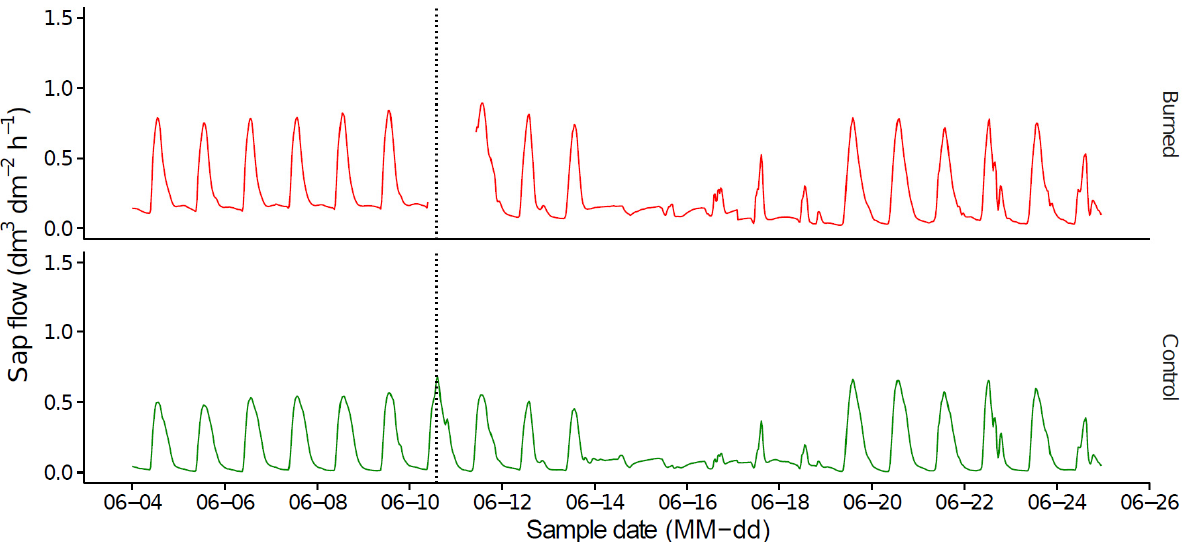
Figure 5. Variations in sap flow from control and burned trees (dm 3 dm – 2 h – 1 ) between 4 June 2014 and 25 June 2014. The curves represent the average value for all trees in each treatment. The dashed vertical line represents the date of the pre- scribed burning.